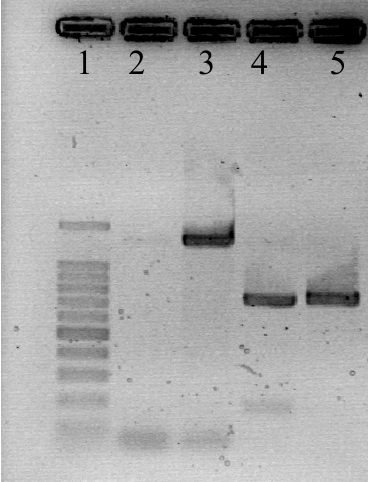
Figure 6. The genus specific identification of Enterococcus samples by PCR Legends